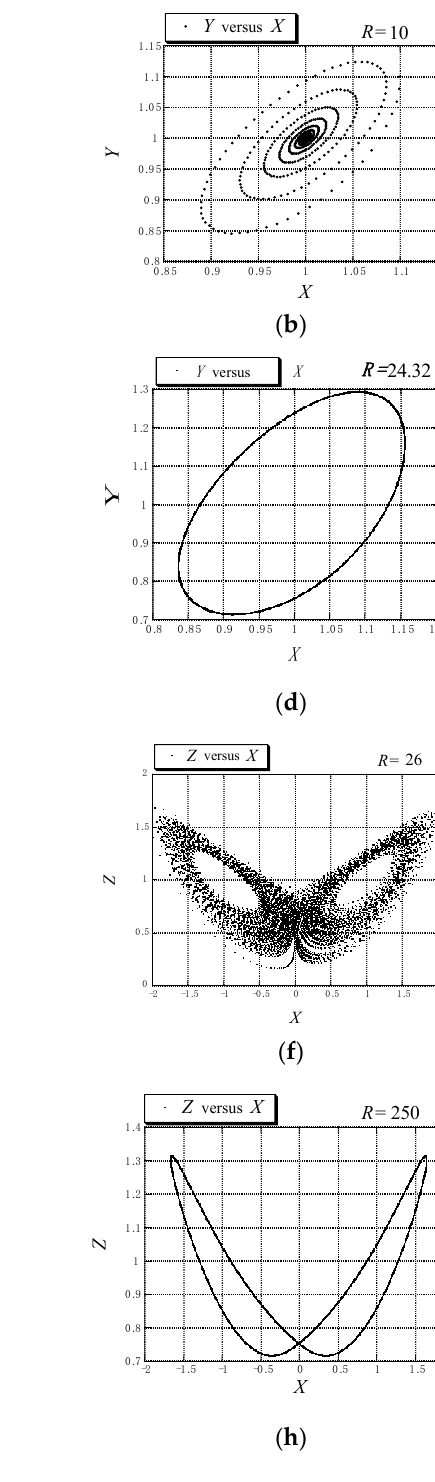
Figure 7. Different transitions in natural convection in a rotating porous layer. (Reprinted from [46], with permission from Elsevier Science Ltd.) ( a ) projection on the Y-X plane for R =1.1; ( b ) projection on the Y-X plane for R =10; ( c ) projection on the Y-X plane for R =23; ( d ) projection on the Y-X plane for R =24.32; ( e ) projection on the Y-X plane for R =26; ( f ) projection on the Z-X plane for R =26; ( g ) projection on the Y-X plane for R =250; ( h ) projection on the Z-X plane for R =250.